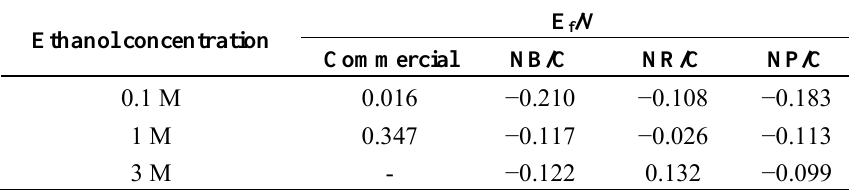
of Commercial Pd/C, NR/C, NB/C, and NP/C catalysts obtained in 1 M KOH Table 1. E f solution at room temperature